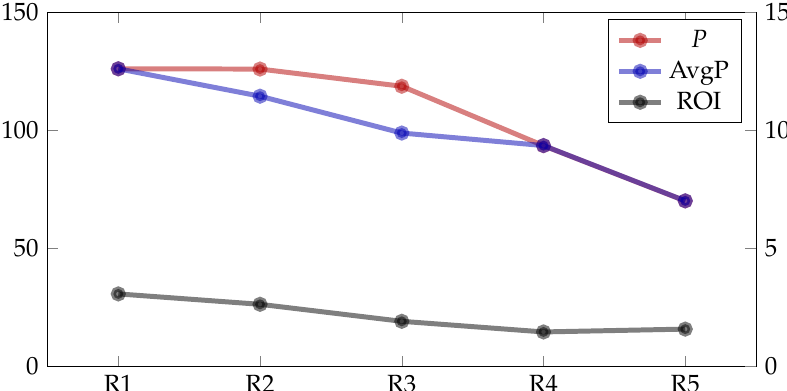
Figure 2. Values of P (left axis) and AvgP and ROI (right axis) indicators obtained using 5 best-rated rules determined to maximize AvgP indicator.